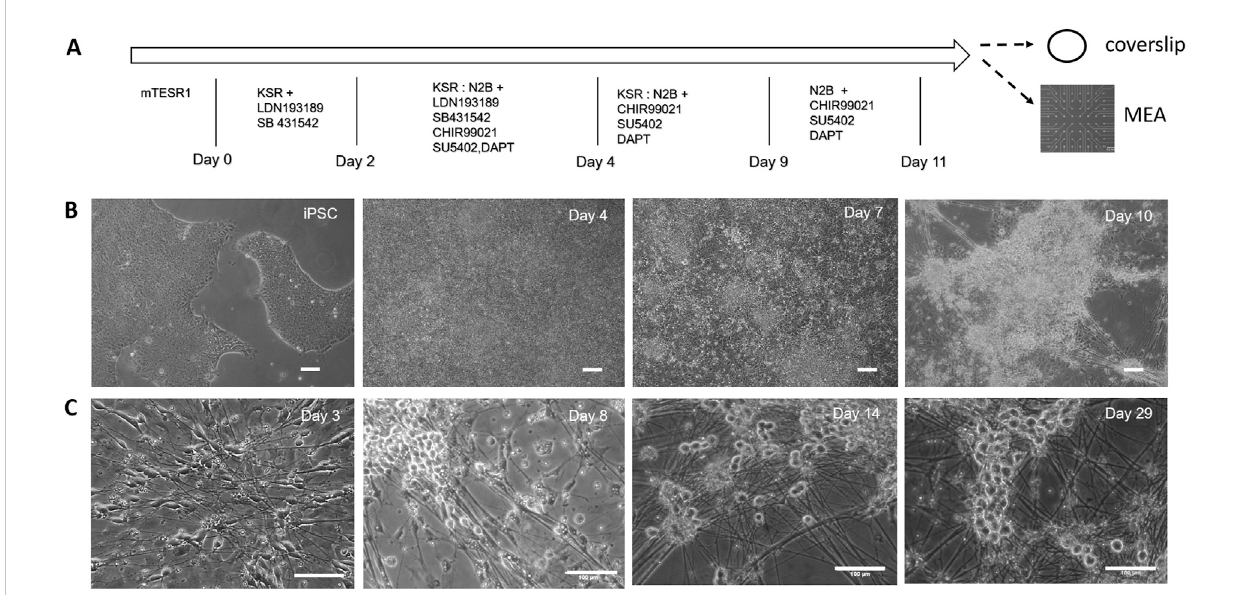
FIGURE 1 Differentiation of nociceptors from hiPSCs characterized by phase microscopy. (A) Outline of the iPSC-nociceptor differentiation process and cell culture procedure. Timeline showing medium changes and inclusion of small molecules at different days during the differentiation process. At the completion of the differentiation process, the cultures were harvested using trypsin and replated onto coverslips for characterization and MEAs for functional analysis. (B) Phase images showing the morphological progression of the iPSC-nociceptor culture during the differentiation process. Once the iPSC colonies reached 70% con fl uency, differentiation is induced. As the differentiation progressed, the con fl uent colonies started to form clusters,whichbecameprominentatDay10ofdifferentiationandthenociceptorsanddifferentiationmayalreadyhavebeeninitiatedassuggestedbythe axonal processes arising from the clusters. Scale bar: 100 μ m. (C) Phase images indicate the morphological progression of the iPSC-nociceptor culture after replating during cell maturation. During the initial phase the cells started showing spindle shaped bipolar morphology. After a few days some of the processesstartedmovingtowardseachothertendingtoformthepseudounipolarmorphology.Post2 weeksthesomatendedtoformclusterssimilarto clusters of sensory neurons found in DRGs. Scale bar: 100 μ